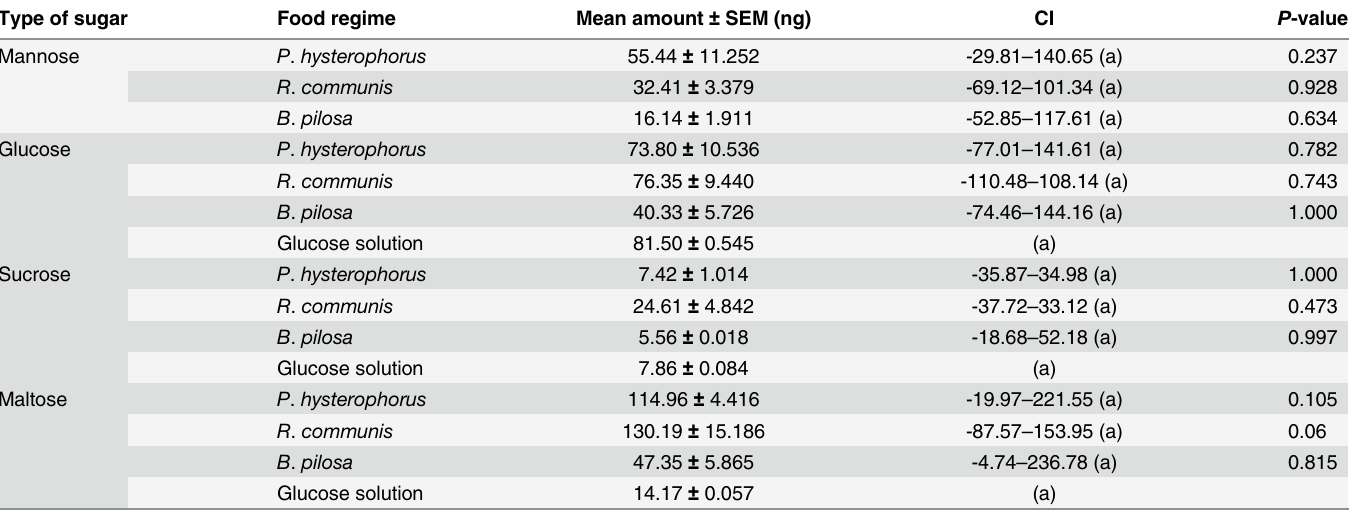
Table 3. Total amount of specific sugars present in An . gambiae mid-gut after feeding on different food regimes. Type of